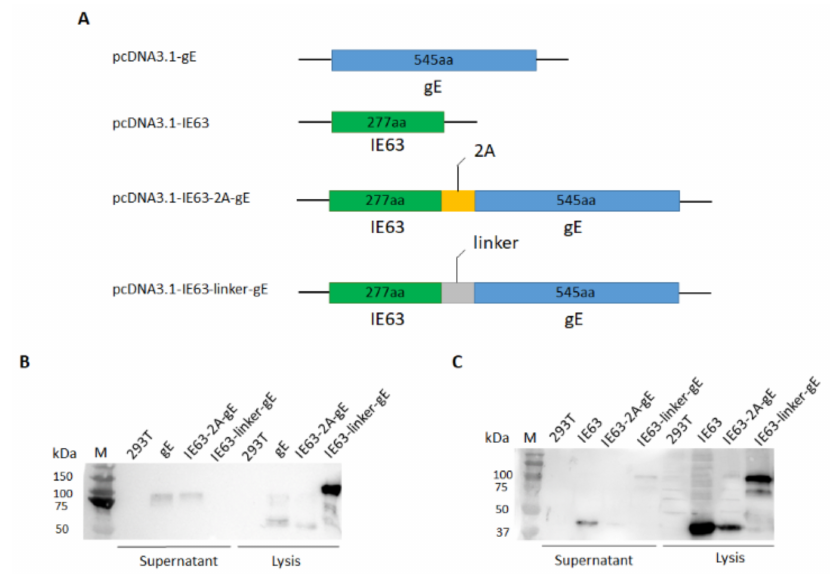
Figure 1. Design of plasmids and the expression in 293T cells detected by western blotting. ( A ). Schematics of the pcDNA3.1-gE, pcDNA3.1-IE63, pcDNA3.1-IE63-2A-gE and pcDNA3.1-IE63- linker-gE designs. ( B ). Expression of the gE protein in the supernatant and cell lysis was probed using mouse anti-gE monoclonal antibody. ( C ). Expression of the IE63 protein in the supernatant and cell lysis was probed using rabbit anti-IE63 polyclonal